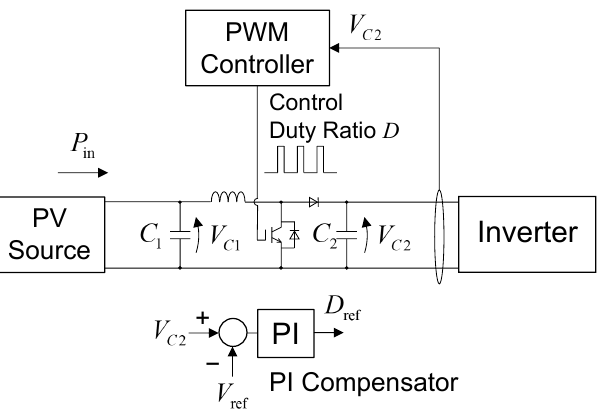
Figure 4. Control Scheme of the secondary side constant voltage control of the DC converter.